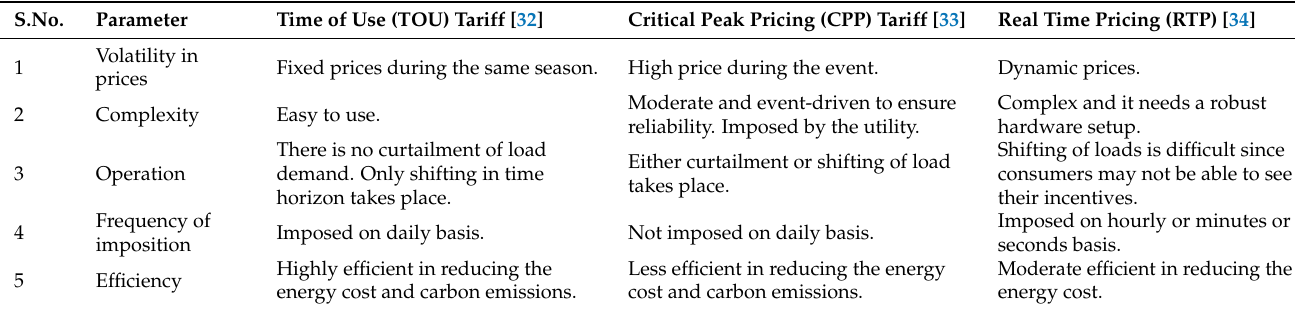
Table 1. Differences between various price-based tariffs